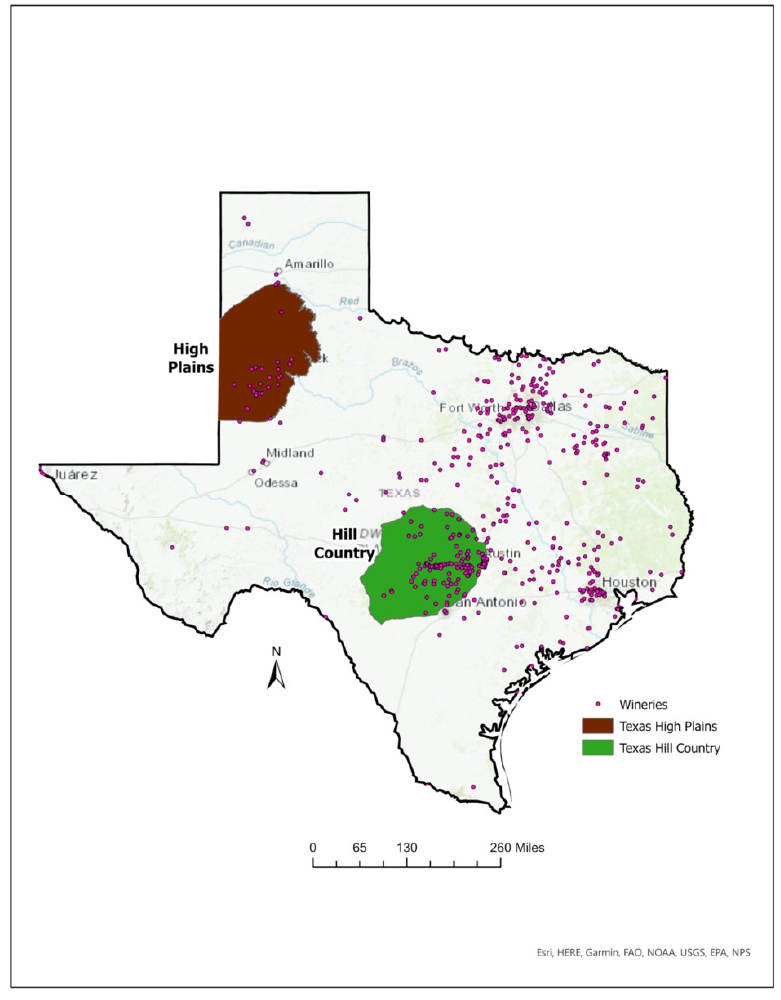
Figure 1. Map of Texas Wineries with the High Plains and Hill Country American Viticultural Areas. (Map by AUTHOR and Nathaniel Dede-Bamfo; September 2020).